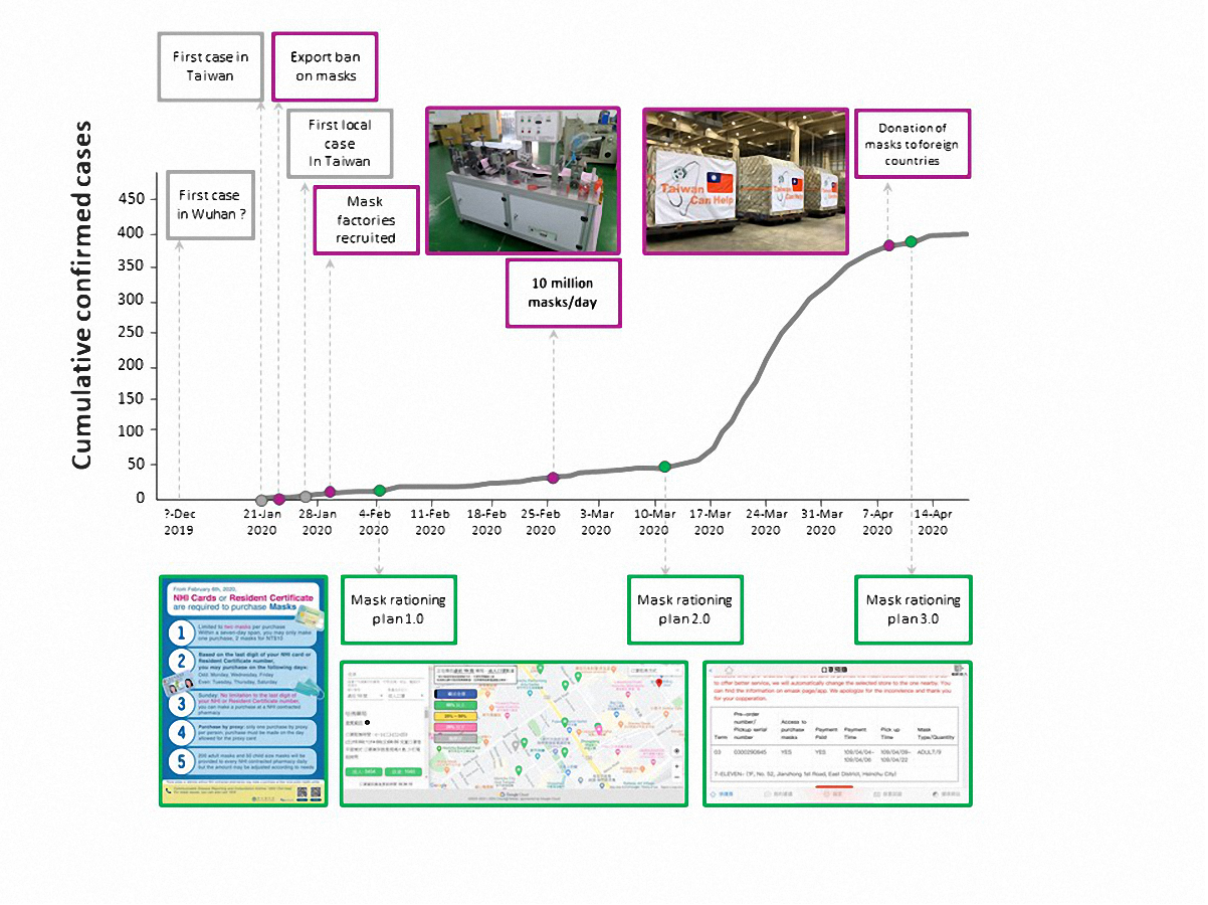
Figure 1. Timeline of confirmed cases in Taiwan and the mask rationing plan. (A) January 21: The first confirmed case in Taiwan. (B) January 24: The first day of the export ban on masks. (C) January 28: The first local case of COVID-19. (D) January 31: Mask factories are identified and provided with mask-making machinery. (E) February 6: Implementation of the mask rationing plan begins. (F) Late February: Mask production was increased from 1 million per day in early February to 10 million per day. (G) March 12: Version 2.0 of the mask rationing plan begins. (H) April 8: Masks are donated to other countries. (I) April 9: Version 3.0 of the mask rationing plan